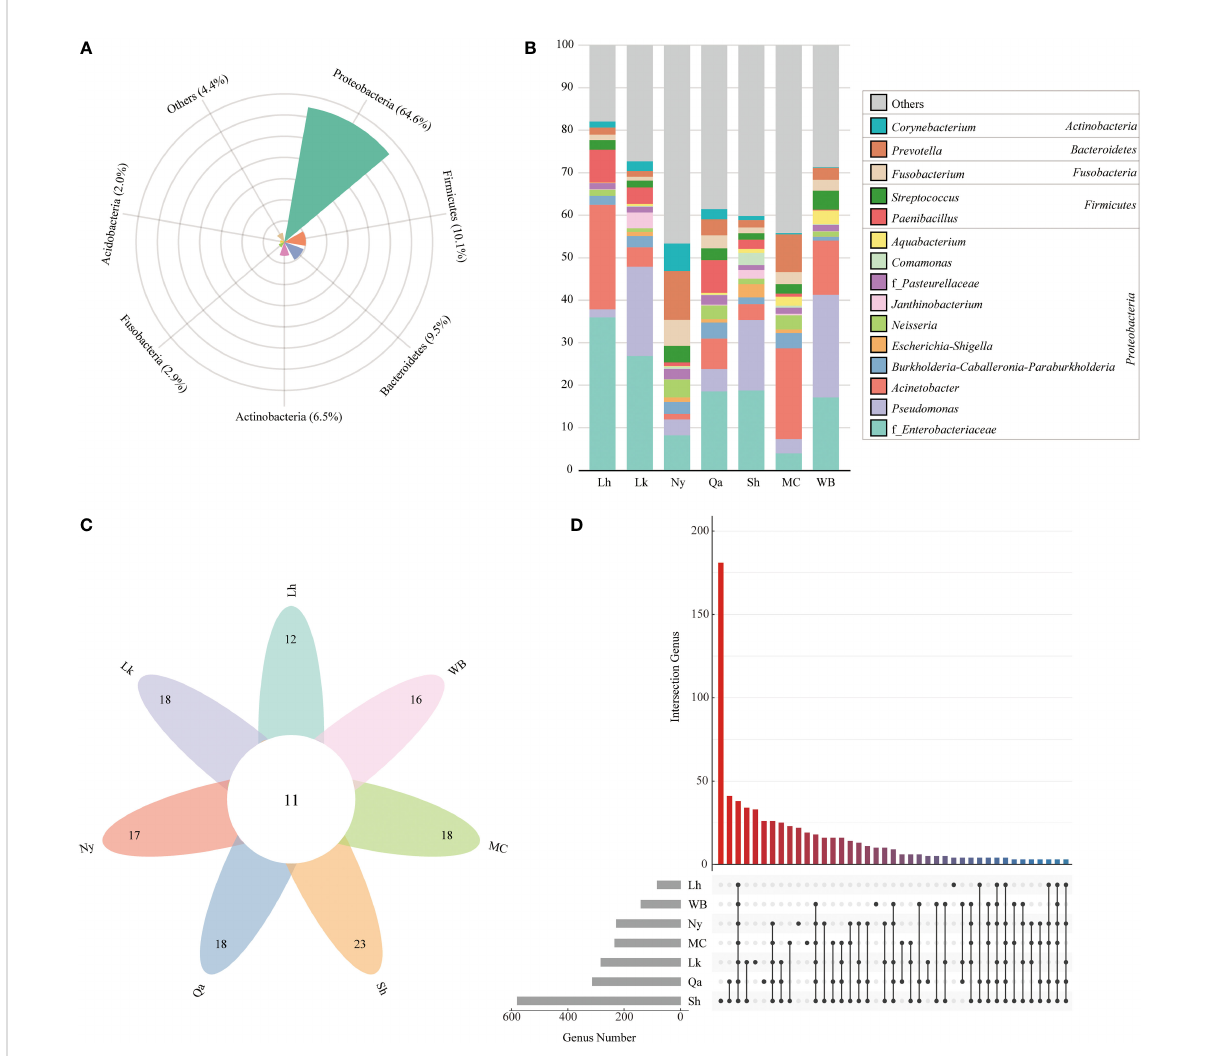
FIGURE 3 Similarity of endophytic bacterial composition of different types of qingke seeds. (A) The composition of endophytic bacteria in qingke seeds. The phyla with abundances below 2% are summarized as “ Others ” . (B) The genus composition of different types of qingke seeds. Taxa